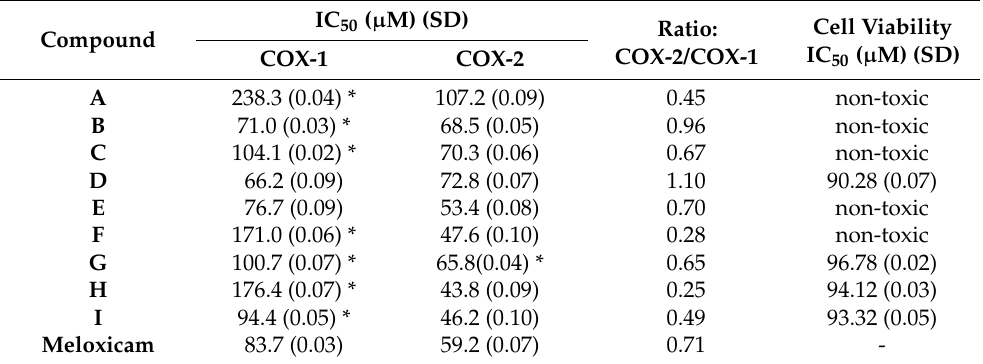
Table 2. IC 50 values calculated for COX-1 and COX-2 enzymes; incubation for 2 min with the tested compounds [mean (SD); n = 3]; statistical significance of COX-1 and COX-2 inhibition calculated with post-hoc test compared to the control Meloxicam (* p < 0.05). IC 50 values were calculated for NHDF cell cultures after 24 h of incubation with the tested compounds A – I .